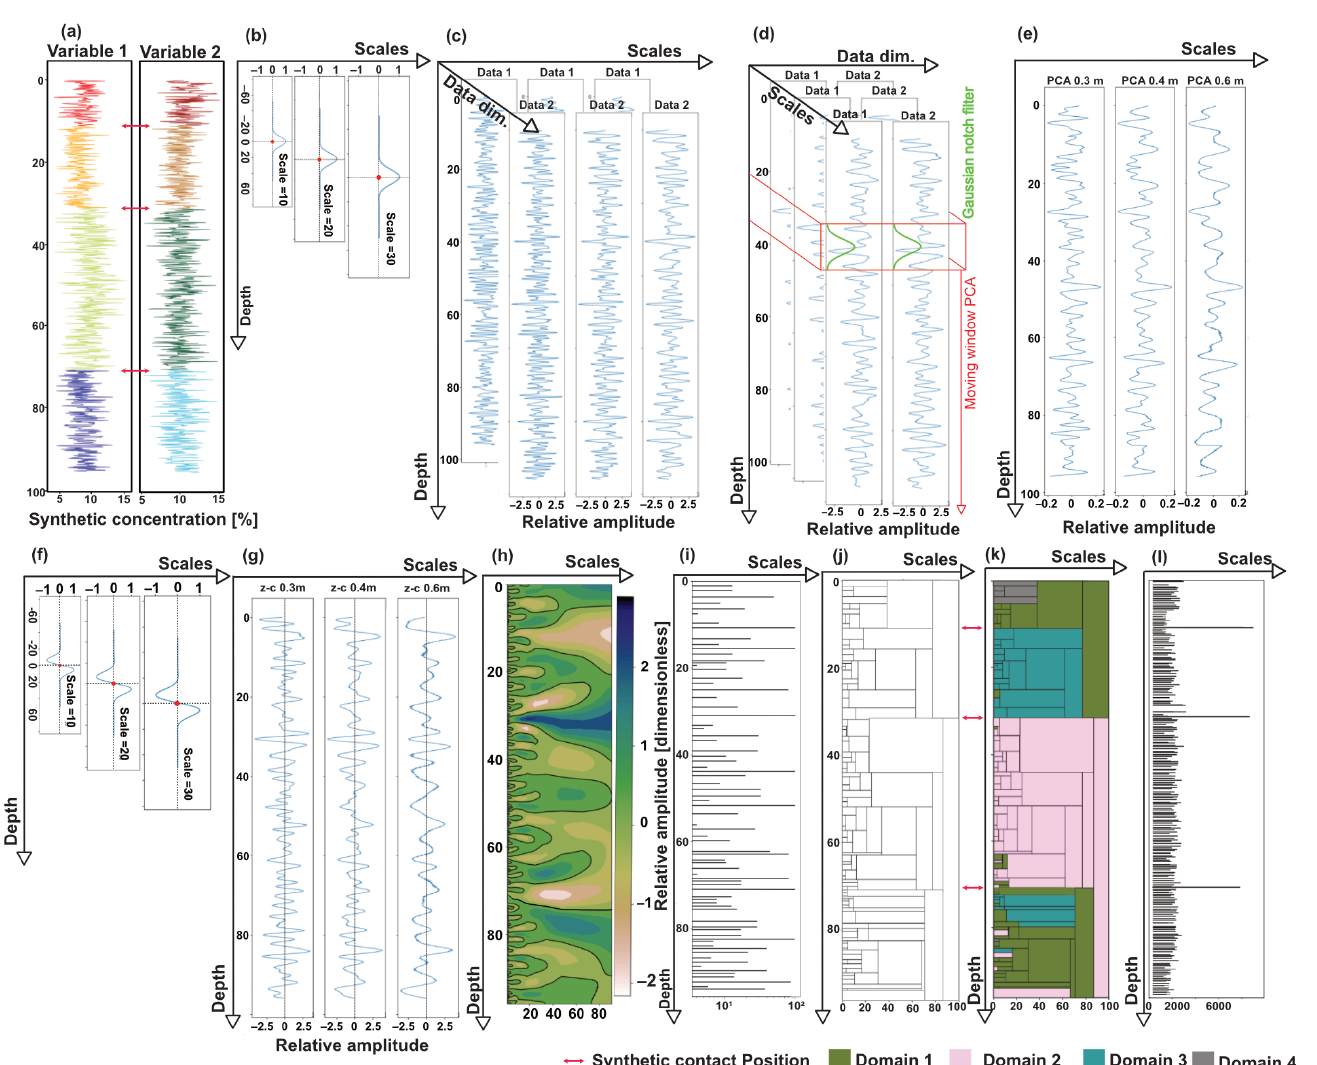
Figure 2. Illustrated workflow applied on a synthetic example. ( a ) Raw multivariate data. The colour scheme of the variables in panel ( a ) is explained in Figure 3. ( b ) Gaussian functions stretched along the scales, which are used as wavelets for the CWT. ( c ) multivariate and multi-scale output after applying the CWT with Gaussian wavelet. ( d ) Illustration of moving-window PCA and Gaussian notch filter. ( e ) First PCA component for each scale. ( f ) First derivative of Gaussian functions stretched along the scales, which are used as wavelets for the second CWT. ( g ) Zero-crossing resulting values along scales. ( h ) Contourmap of zero-crossing values along scales. ( i ) Geological domains extracted boundaries. ( j ) Scalogram i.e., multi-scale borehole segmentation. ( k ) Scalogram with color scheme guided by resulting domains. ( l ) Cumulative sum of contact boundaries after 100 realizations based on the same